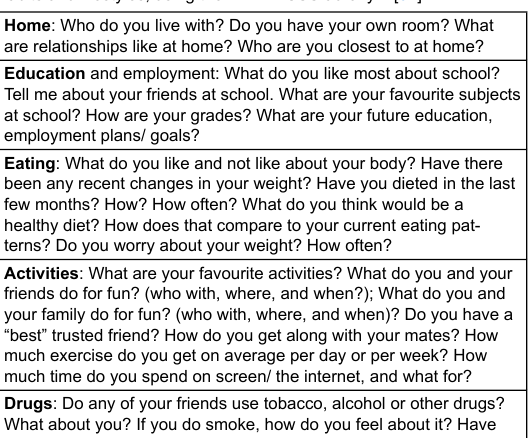
Table 1: Some examples of how to assess an adolescent’s health habits and lifestyles, using the HEEADSSS acronym [37]. Home : Who do you live with? Do you have your own room? What are relationships like at home? Who are you closest to at